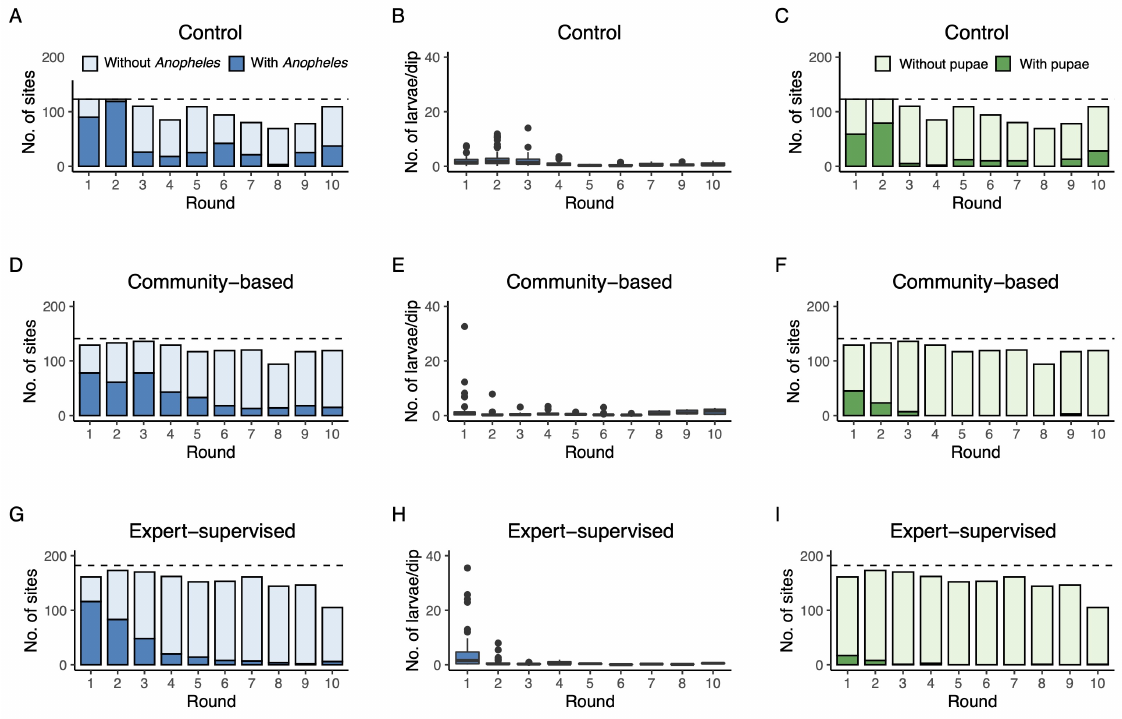
Figure 3. Number of sites with and without Anopheles larvae per survey round in the control arm (panel ( A )), number of Anopheles larvae per dip per survey round in the control arm (panel ( B )), and number of sites with pupae per survey round in the control arm (panel ( C )). Similarly, in panels ( D – I ), the same outcome parameters are shown for the CB arm and ES arm, respectively. The dashed horizontal lines represent the maximum number of sampling sites that were selected per intervention arm (see Table